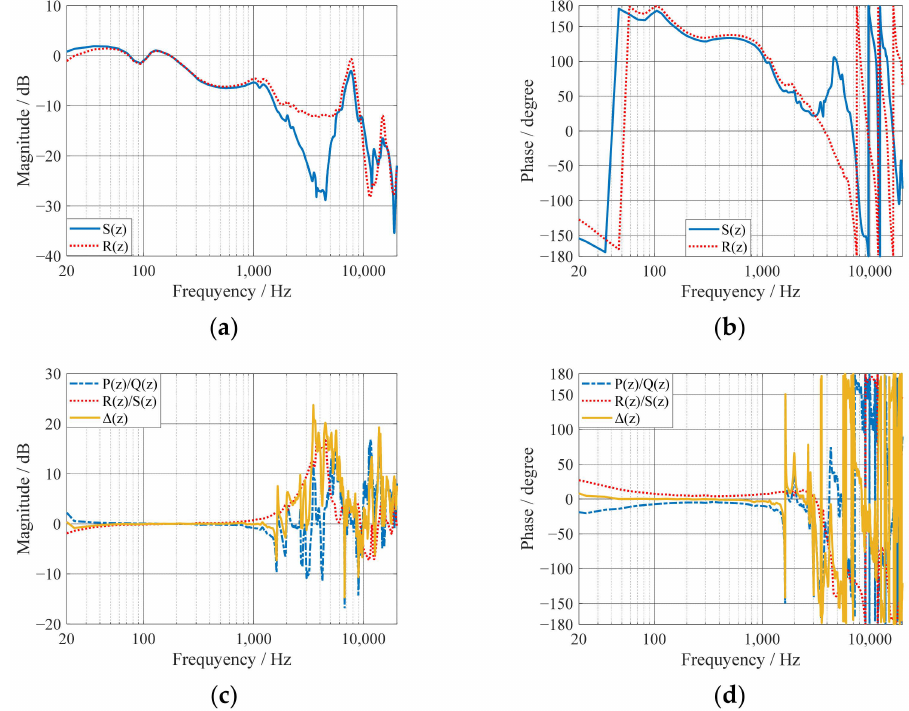
Figure 3. Tested FRs of the experimental system: the ( a ) magnitude and ( b ) phase responses of the secondary paths, the ( c ) magnitude and ( d ) phase responses of the frequency